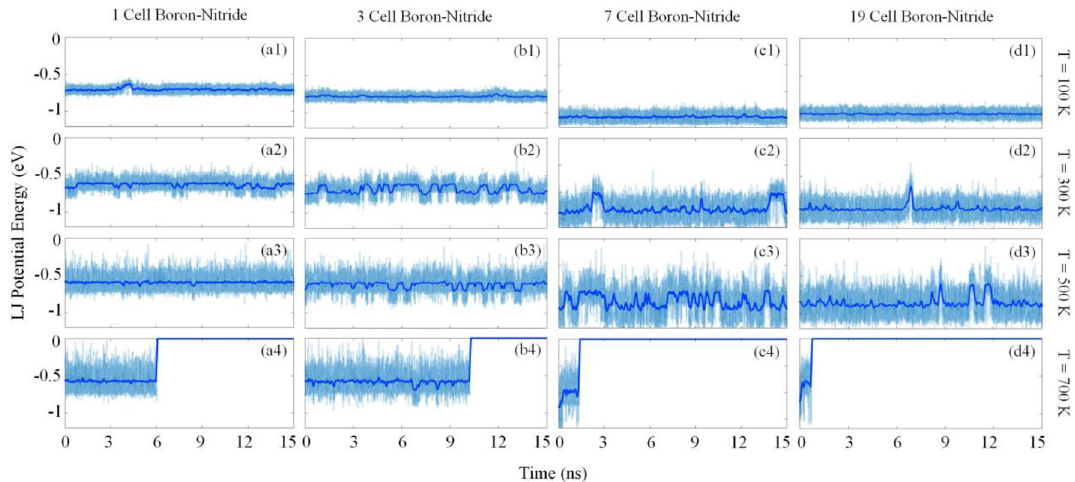
Figure 5. The Lennard–Jones interaction between C 60 and graphene substrate with boron-nitride impurity. As presented, desorption has occurred in all impurity types at 700